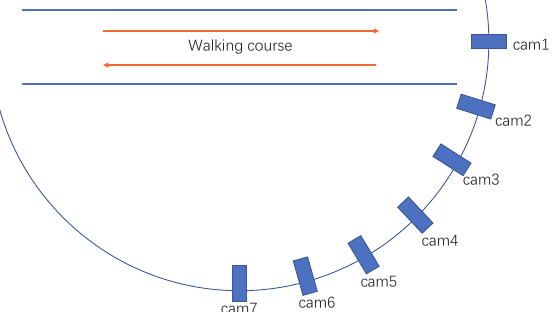
Figure 8. The setup of cameras in collecting data for the Multi-state dataset. There are 7 Hikvision cameras applied in this scene and the interval between two adjacent cameras is 15 degrees. The subject person was instructed to walk forward and backward along the same route.